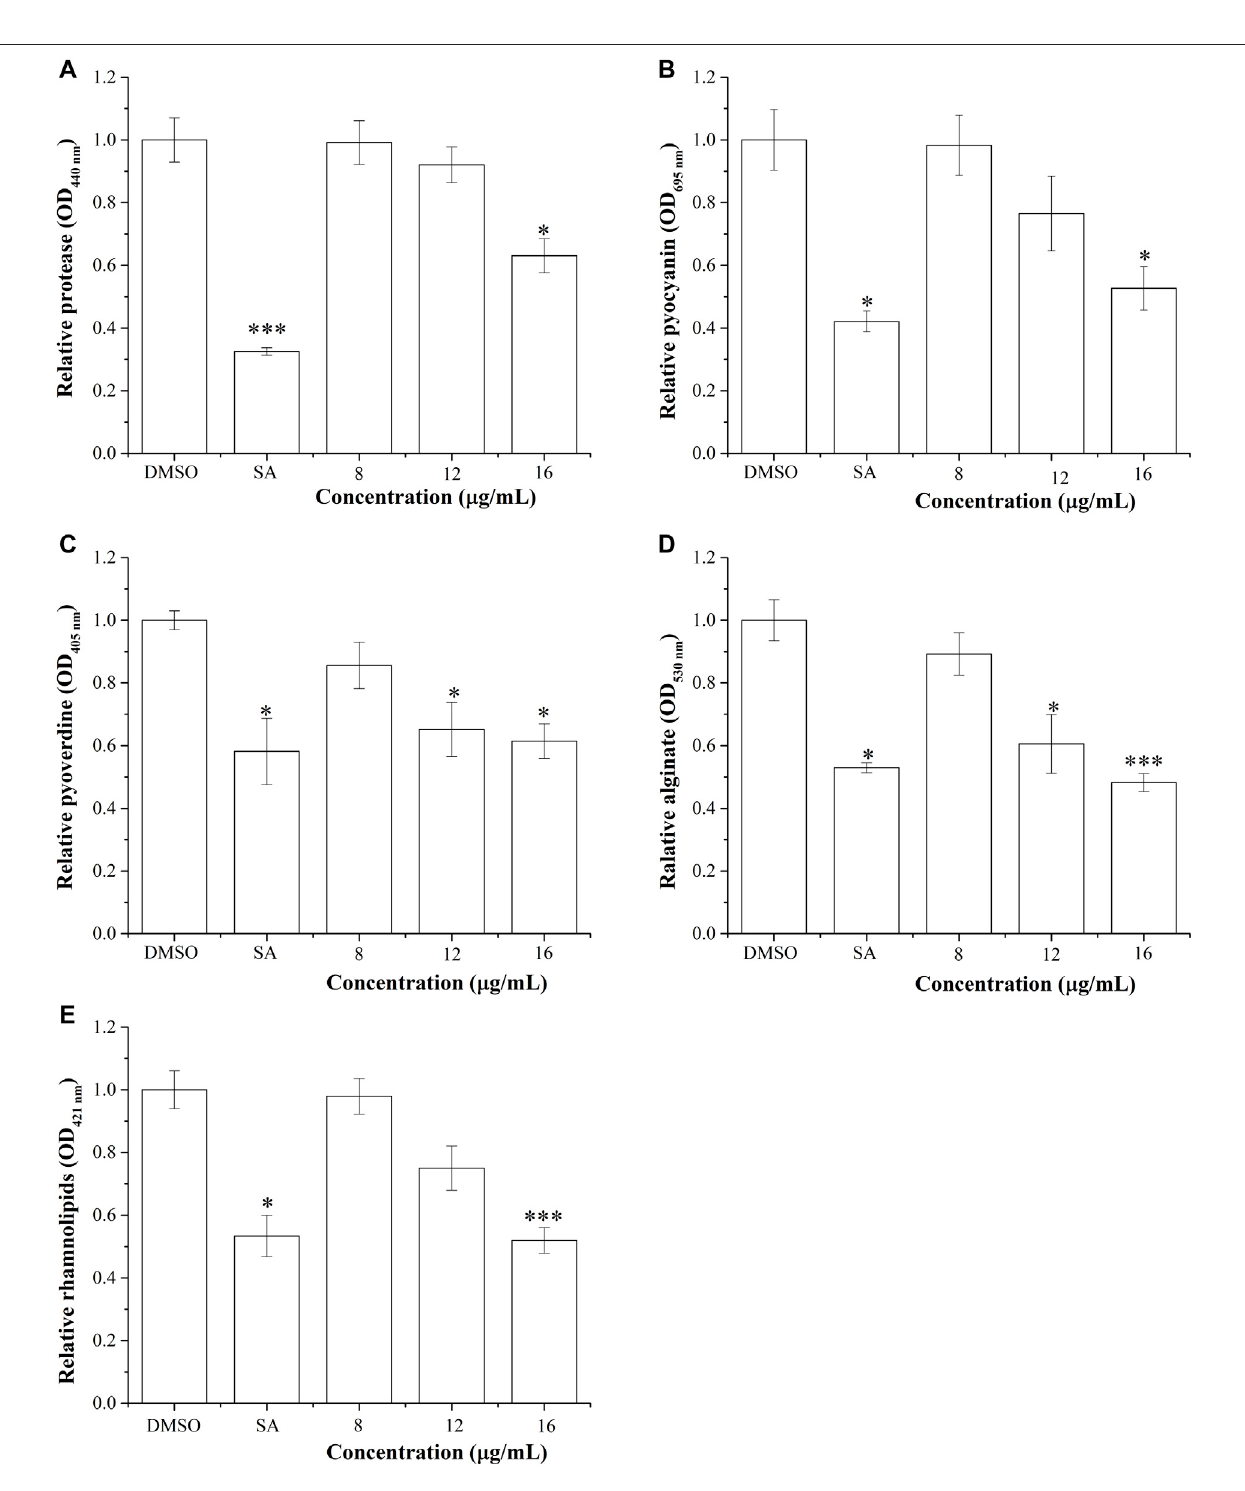
FIGURE 6 | Effect of BG138 on virulence factors secreted by P. aeruginosa PA2. Relative levels of virulence factors at different BG138 concentrations (8, 12, and 16 μ g/ml) weretested.DMSO and salicylicacid wereused asnegativeand positive controls. (A) protease levels, (B) pyocyaninlevels, (C) pyoverdinelevels, (D) alginate levels, and (E) rhamnolipid levels. Statistical differences were determined by ANOVA followed by Tukey test. p < 0.05 (*) p < 0.01 (***) versus DMSO control.